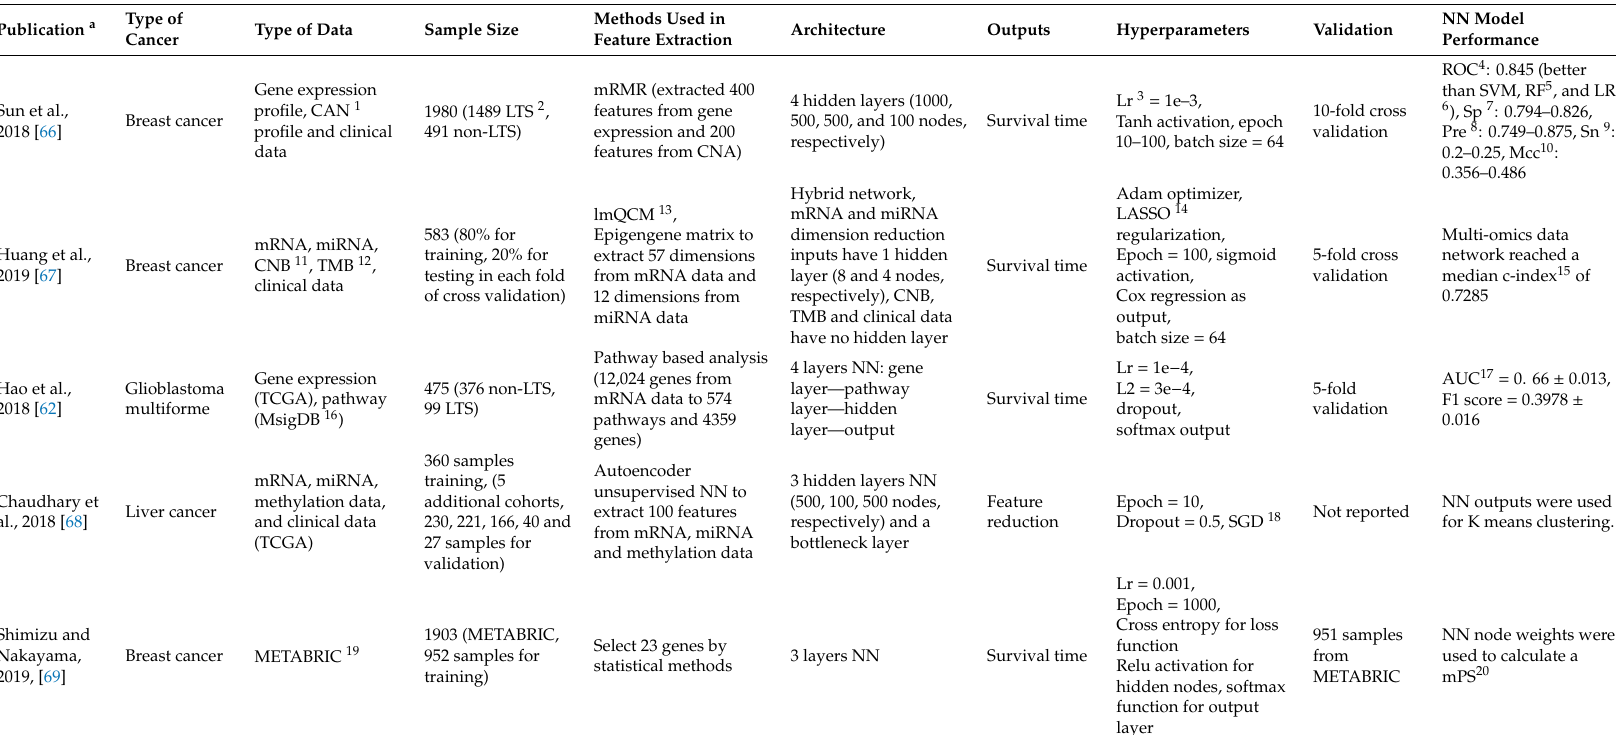
Table 2. Summary of neural network models that used feature